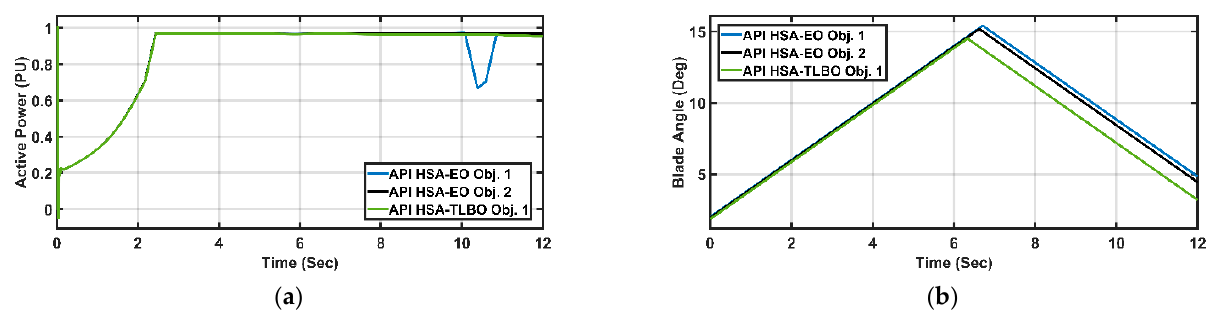
Energies 2021 , 14 , x FOR PEER REVIEW Figure 16. ( a ) Active power responses of normal second case. ( b ) Blade-angle responses of normal second case.